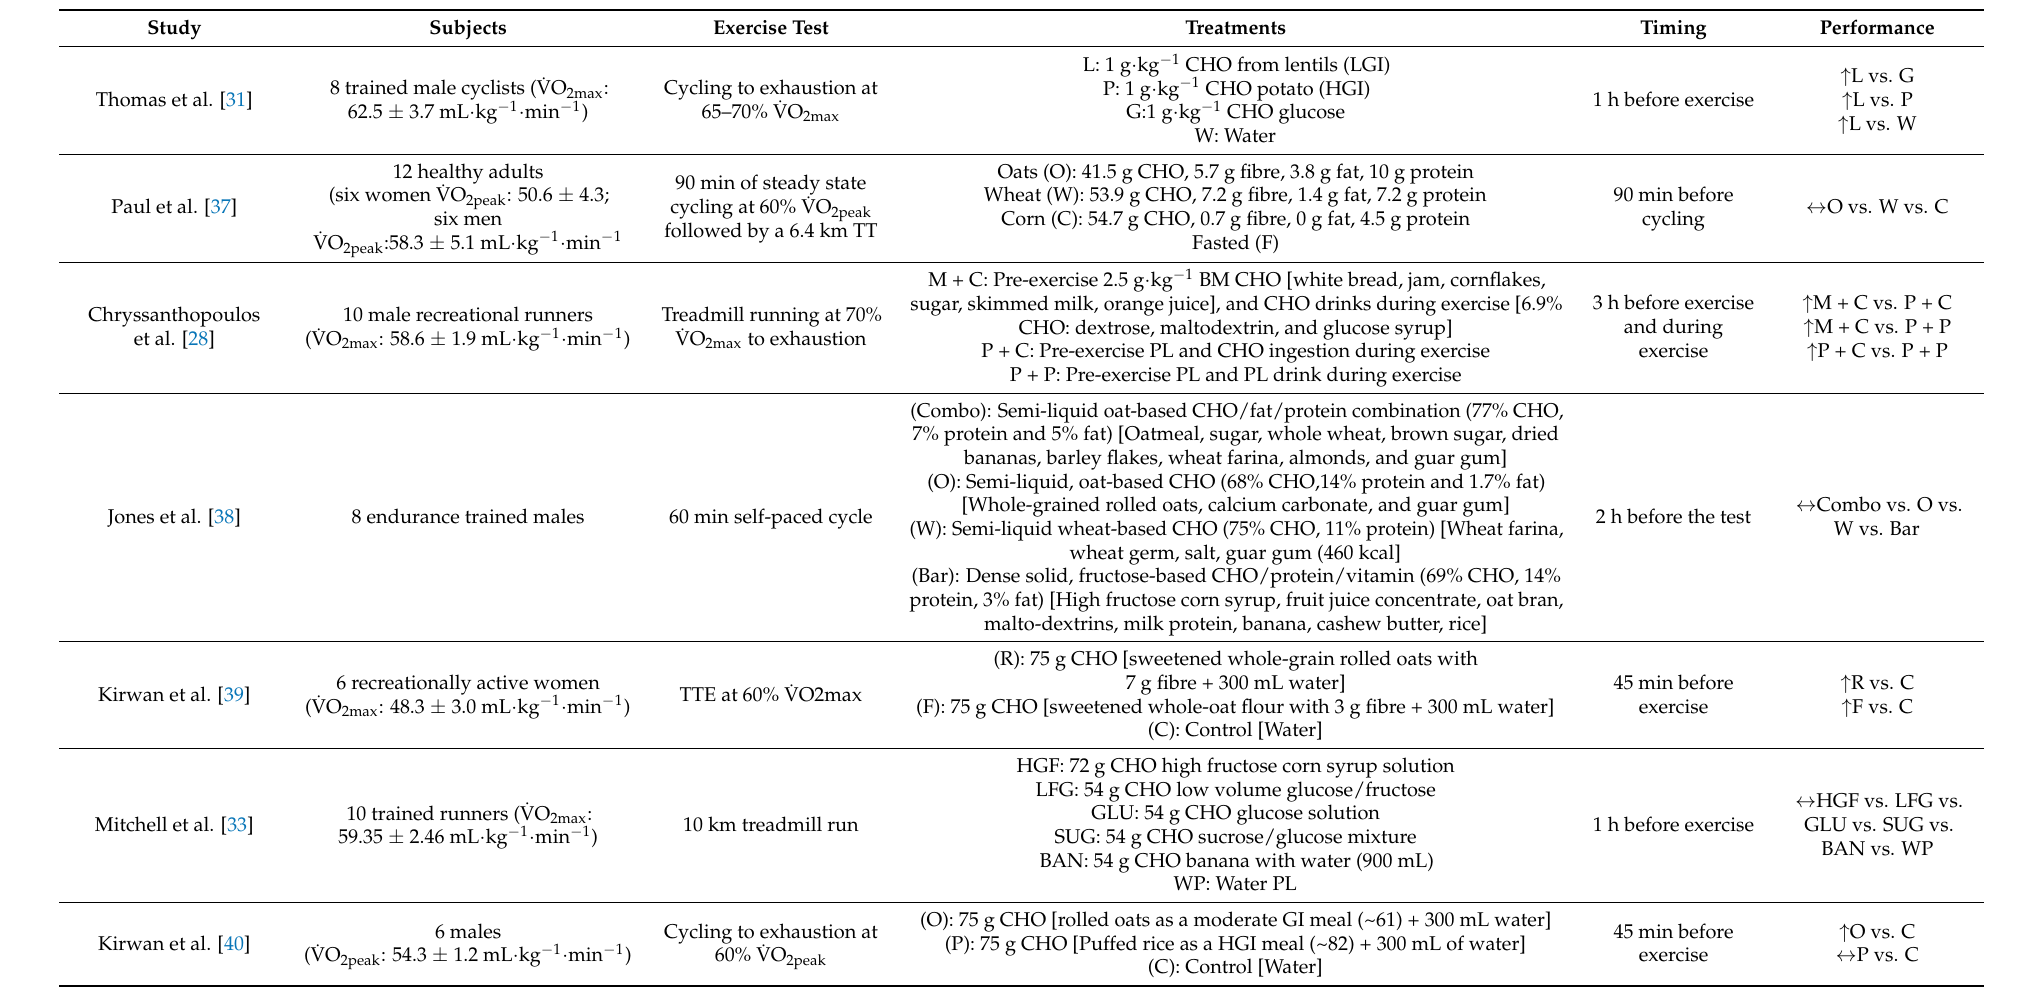
Table 1. Summary of studies exploring the effects of pre-exercise CHO food ingestion on endurance exercise